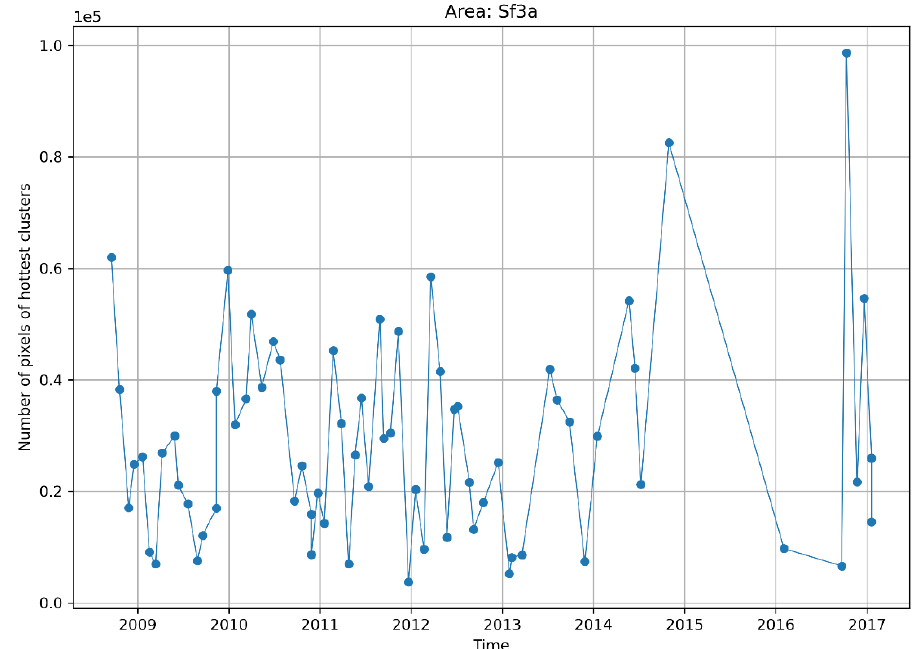
Figure 13. Trend of the average number of pixels of the three hottest clusters of the thermal images taken in La Solfatara crater (Campi Flegrei), indicated as “Sf3a” in Figure 1, acquired between 2008 and 2017.